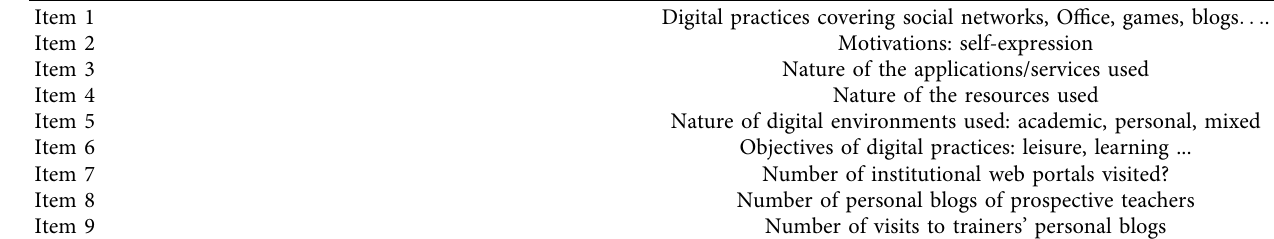
Table 1: Structure of the first part of the